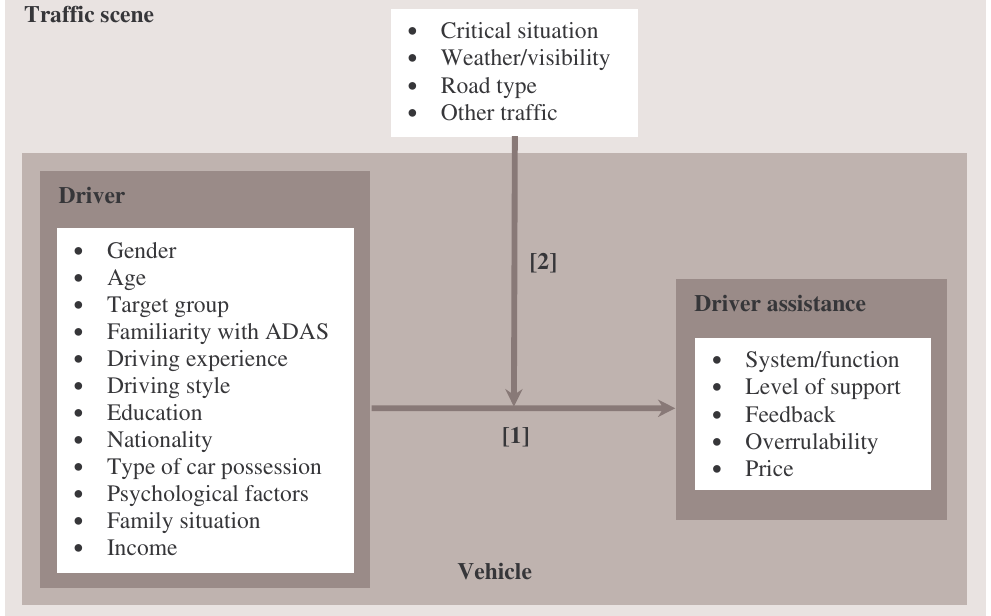
Figure 1. Conceptual framework of user needs for driver